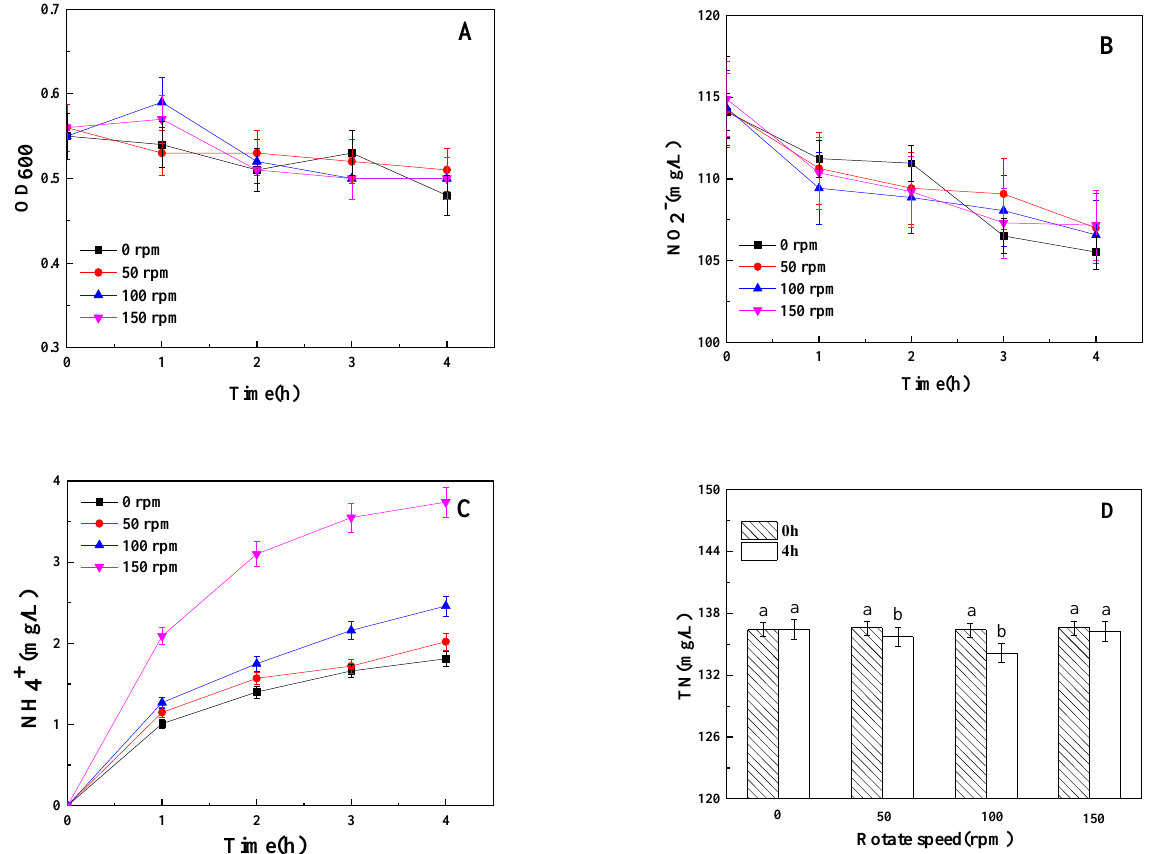
Figure 5. Influence of DO on OD 600 ( A ), NO 2 − ( B ), NH 4+ ( C ), and TN ( D ) by strainY-9. Values are means ± SD for triplicates. Different letters indicate significant differences between treatments at p < 0.05.